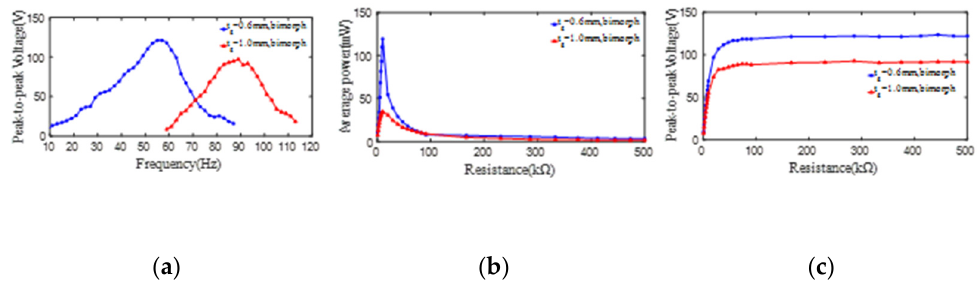
Figure 8. The effect of the substrate thickness on the peak-to-peak voltage and average power of two PZT4 patches bonded on the substrate. ( a ) peak-to-peak voltage versus excitation frequency; ( b ) average power versus load resistance; ( c ) peak-to-peak voltage versus load resistance.